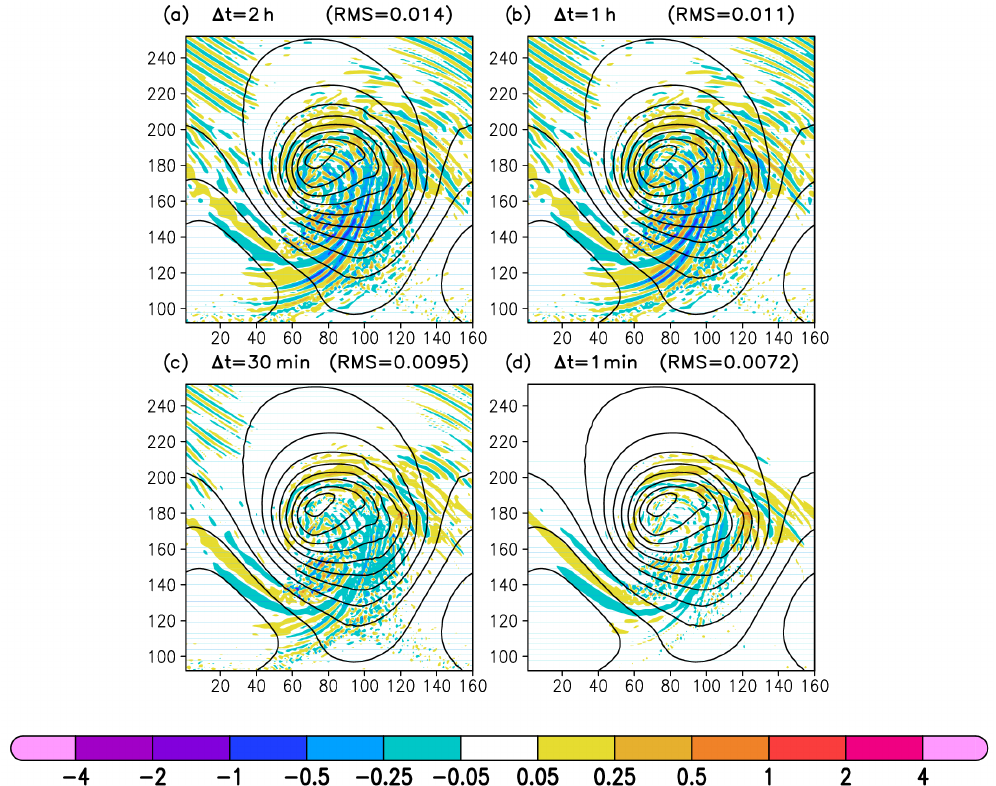
Figure 2. The difference ω TOT − ω WRF at 700hPa level at time 118h at (a) 2h, (b) 1h, (c) 30min and (d) 1min time resolution in the computation of the imbalance term. Unit is Pas − 1 .